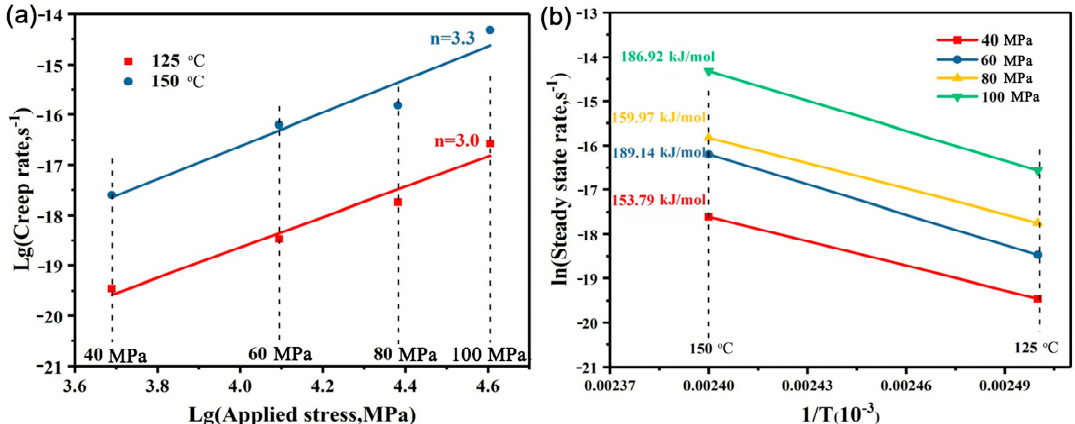
Figure 8. Variation of the steady creep rate against applied stress and temperature.